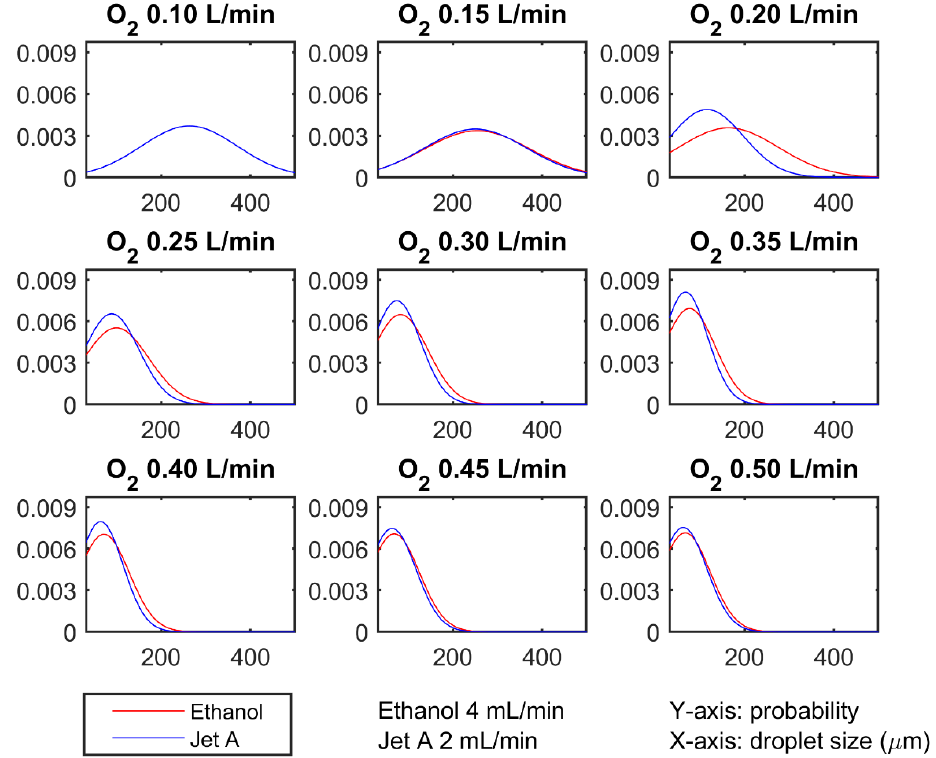
Figure 4. Droplet probability vs. droplet diameter for ethanol and Jet A spray shadowgraphs from Figures 1 and 2. The probability distribution functions were calculated for 100 images at each flow rate for detected droplets up to 500 µm in diameter.